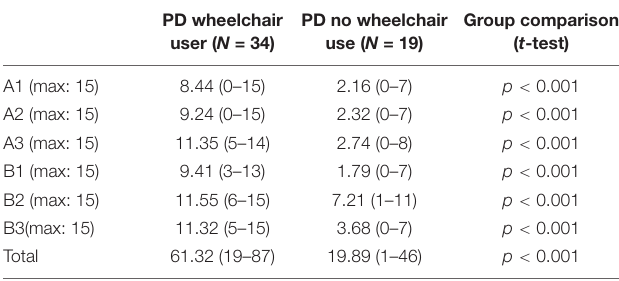
TABLE 5 | Movement ABC checklist profile of scores for the PD groups (a higher score indicates higher severity). PD wheelchair PD no wheelchair Group comparison user ( N = 34) use ( N = 19) ( t